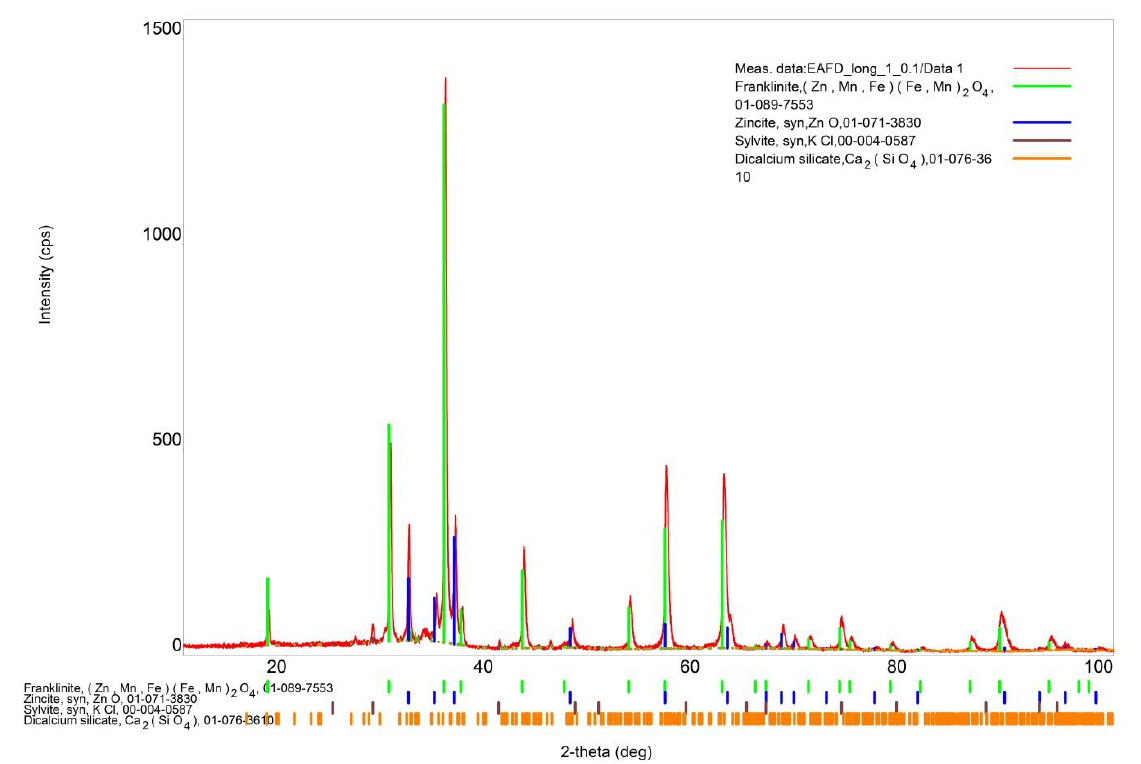
Figure 1. XRD analysis of steelmaking dust.